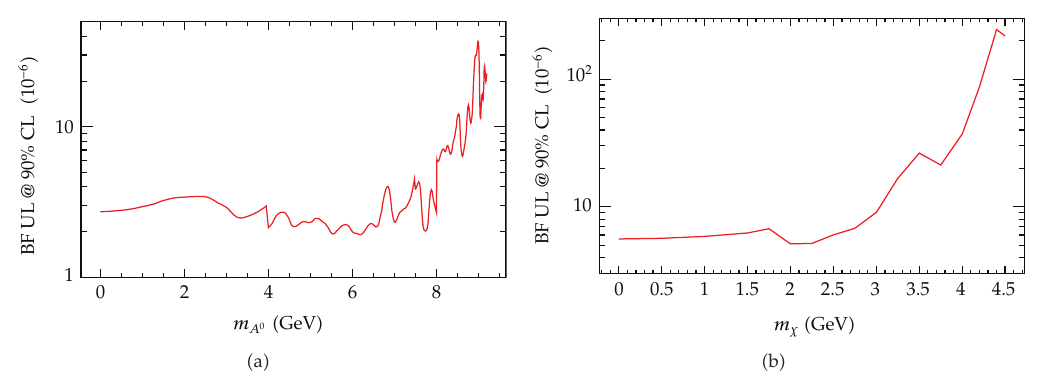
Figure 2: 90% CL upper limits on the Υ(cid:2) 1 S (cid:3) → γA 0 , A 0 → invisible (cid:2) a (cid:3) and Υ(cid:2) 1 S (cid:3) → γA 0 , A 0 → χχ (cid:2) b (cid:3) branching fractions as a function of the A 0 and χ masses set by BABAR